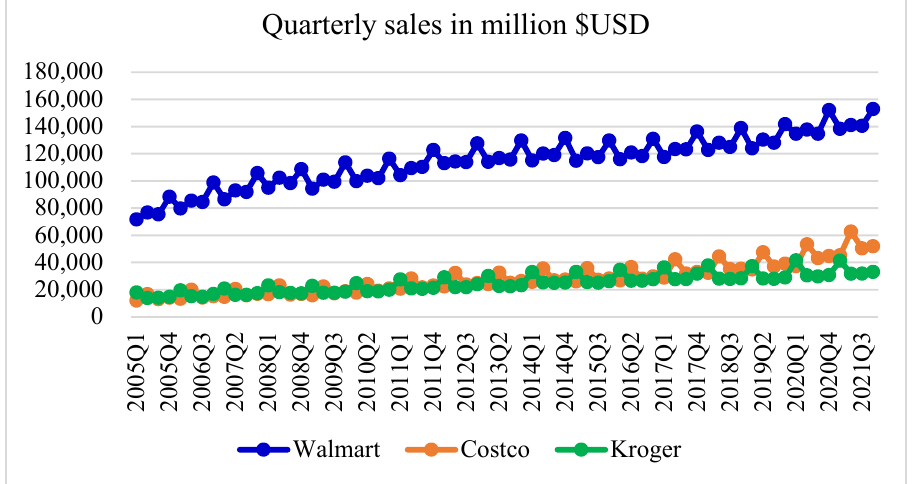
Figure 5. Quarterly sales revenues for the three US firms (in millions $USD). Table 3. Identified economic indicators for the three US retailers using Lasso. * means significant